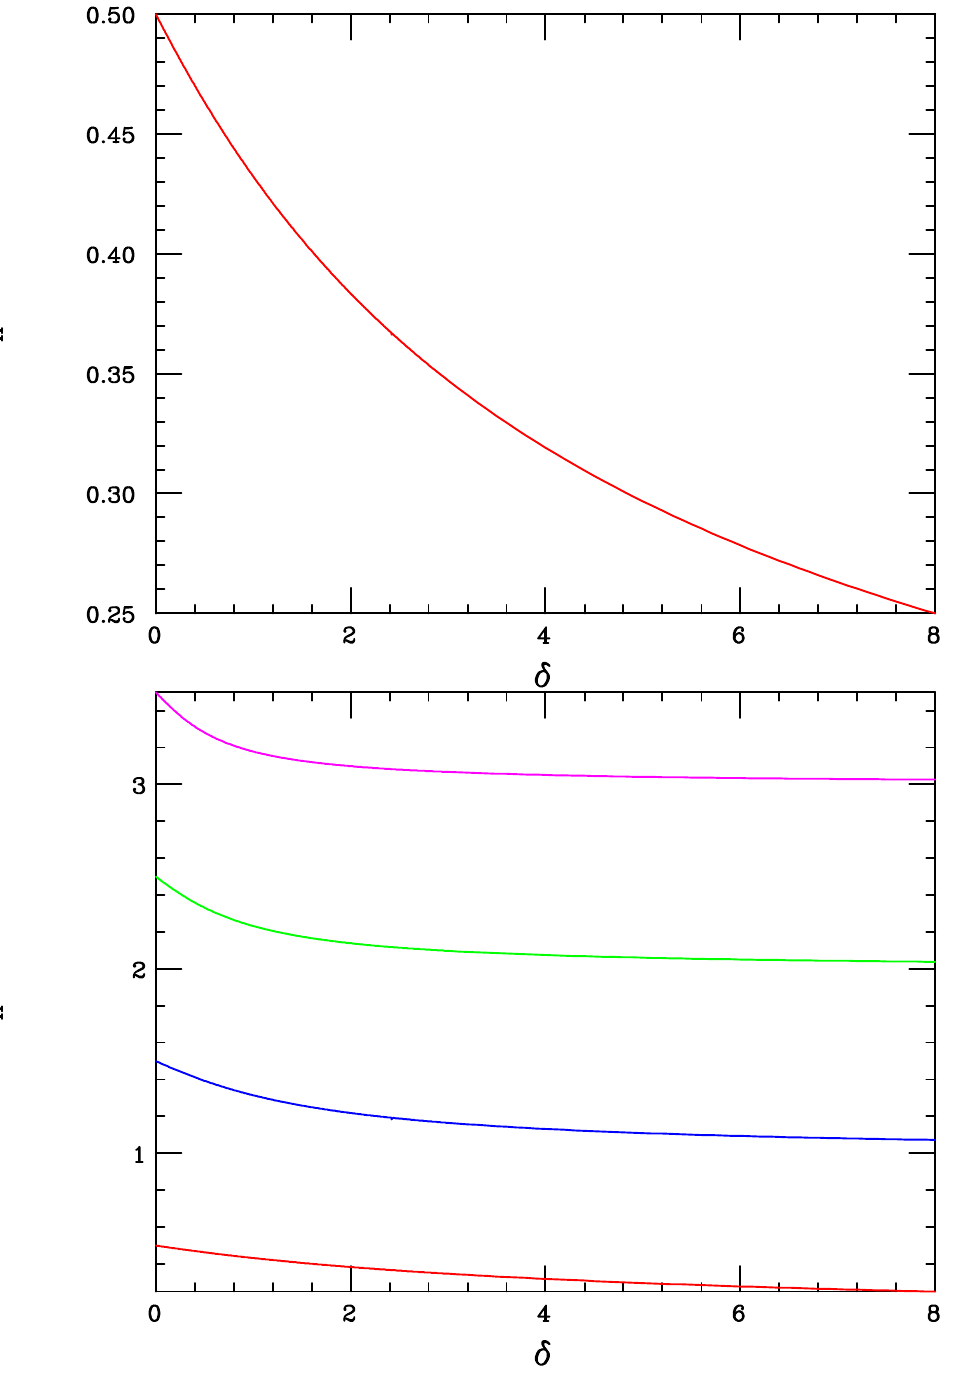
Figure 3 . Top: lowest lying root x n =0 as a function of the BLKT parameter (cid:14) (for both vectors or scalars) as we discuss in the text. Bottom: same as top panel but now, from bottom to top, for x n =0 ; 1 ; 2 ; 3 .